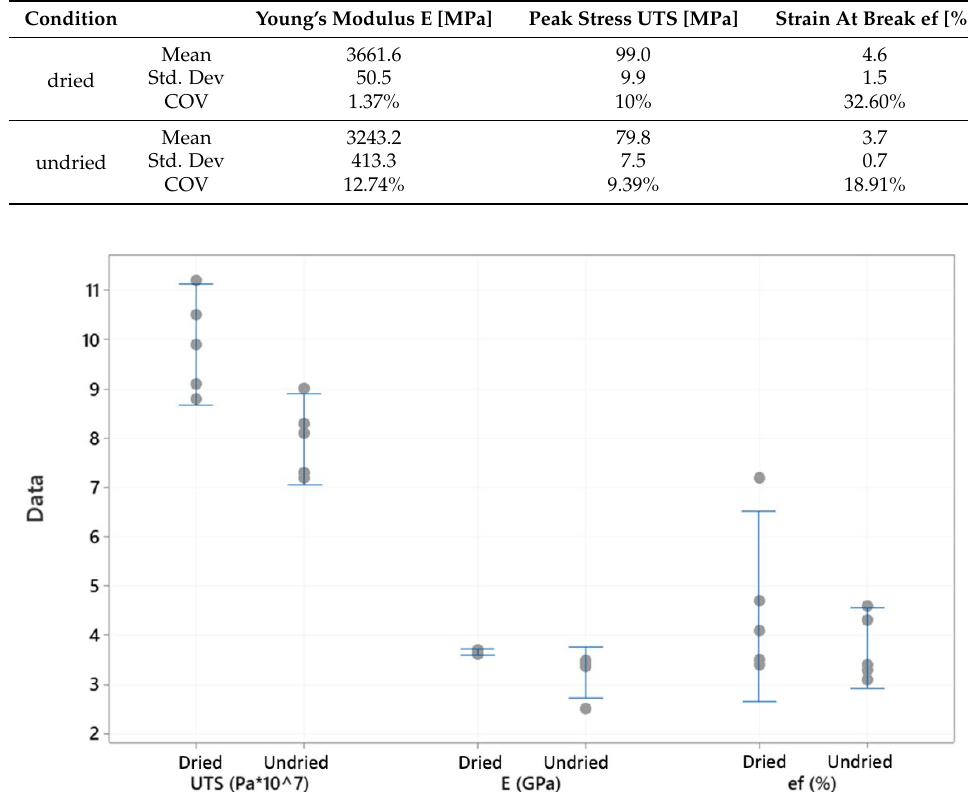
Figure 4. Tensile mechanical properties comparison of dried and undried samples; individual data and interval plots (95% confidence intervals or the mean value) are shown.